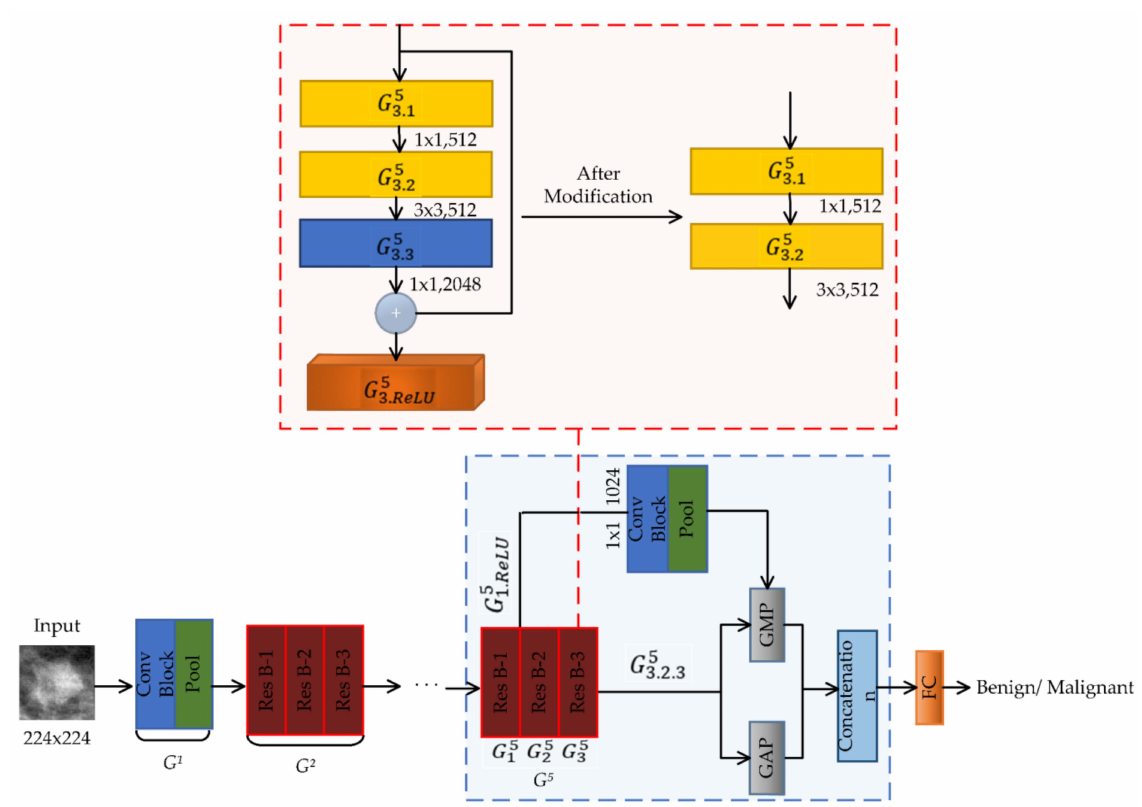
Figure 6. DIResNet-50